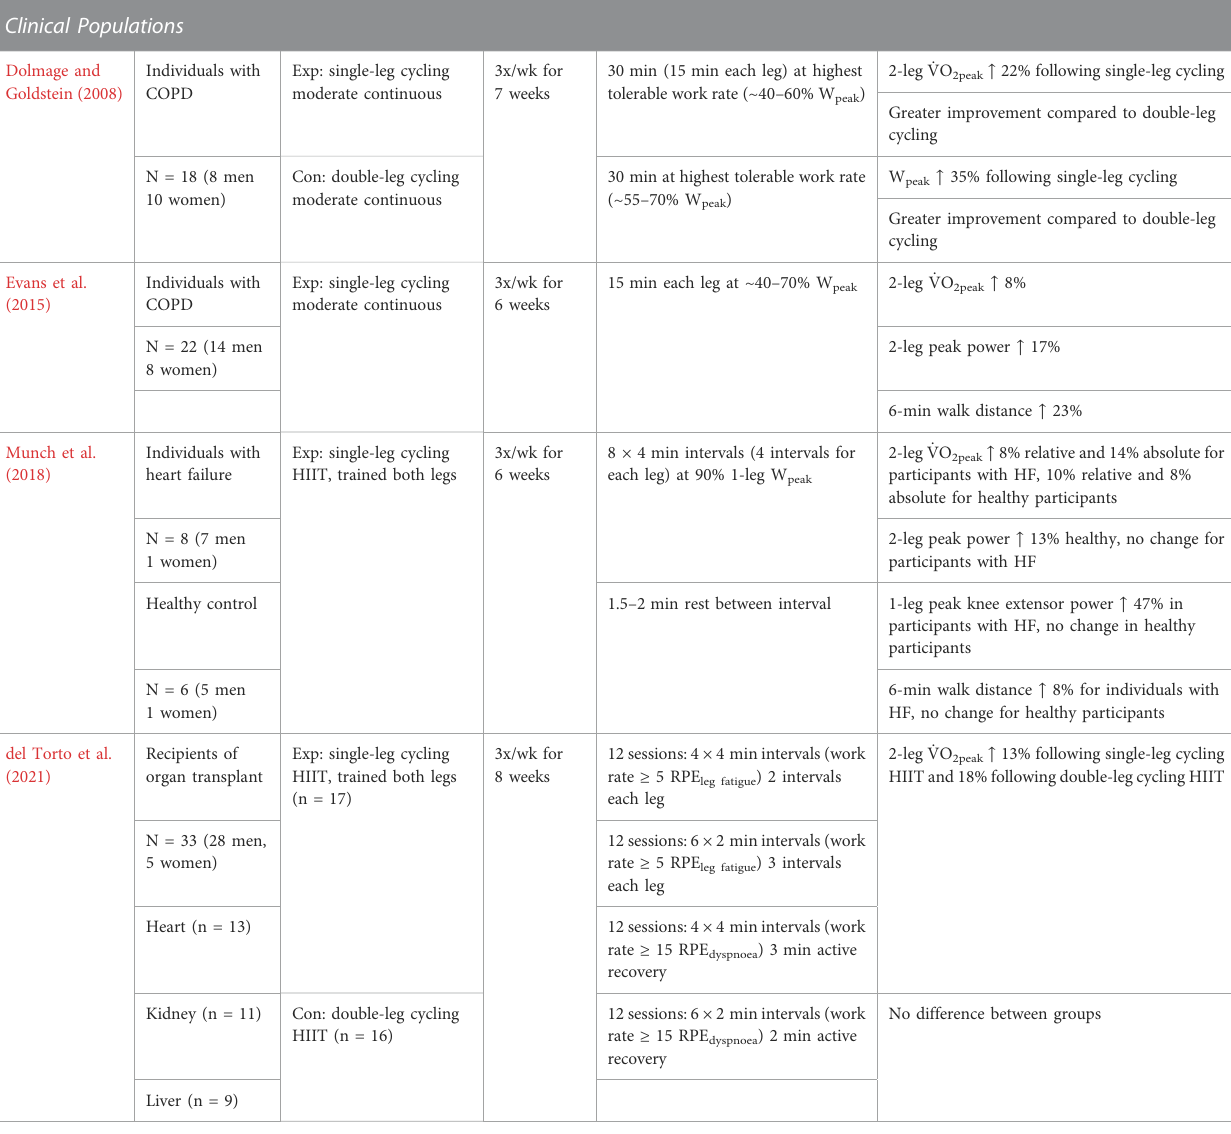
Table1 Notes :Exp,experimentalcondition;con,controlcondition;HIIT,high-intensityintervaltraining; _ VO 2peak ,peakoxygenconsumption;HR peak ,peakheartrate;W peak ,peakpowerreached during incremental _ VO 2peak test; RPE, rating of perceived exertion.